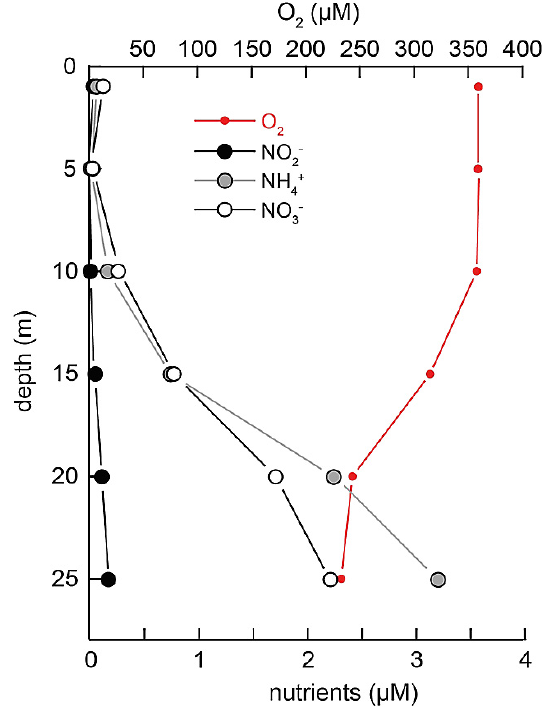
Fig. 2. Nutrient and O 2 concentration in the water column in April 2010. Data were raised as part of the routine monitoring at Boknis Eck (Bange et al.,